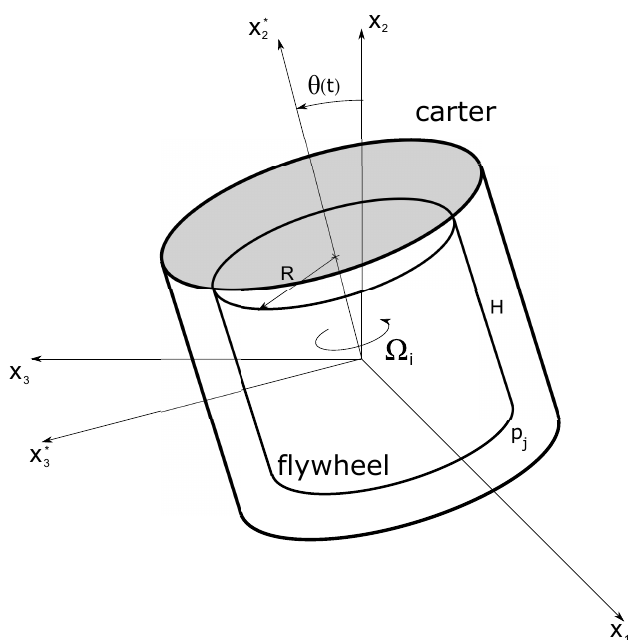
Figure A1. Schematic representation of the absolute and non-inertial frames of